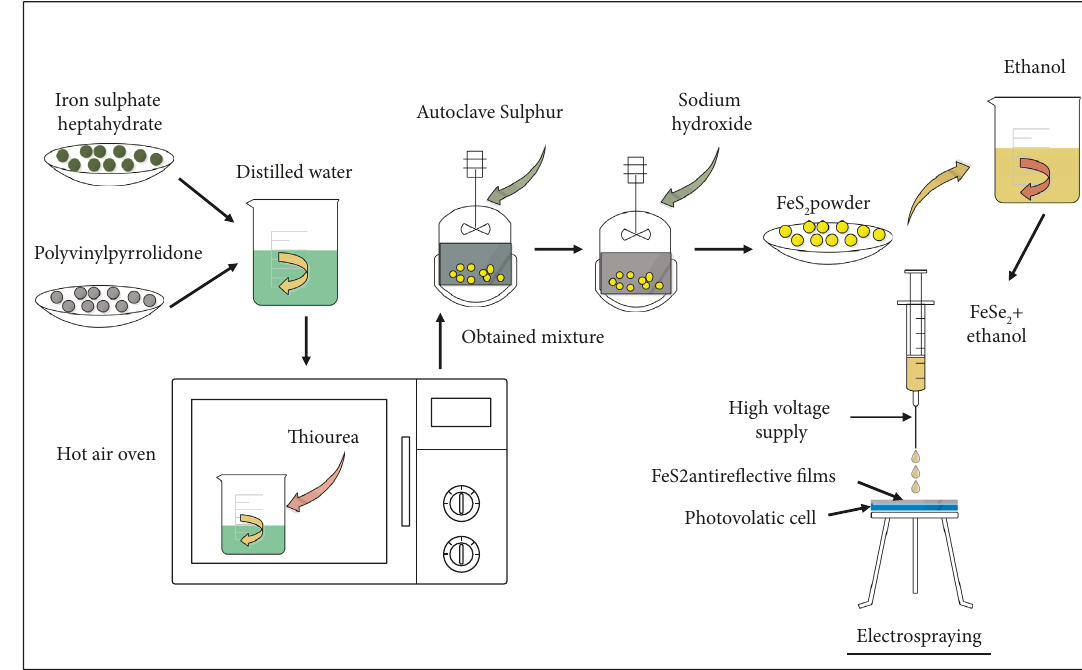
Figure 1: Synthesis and coating of FeS